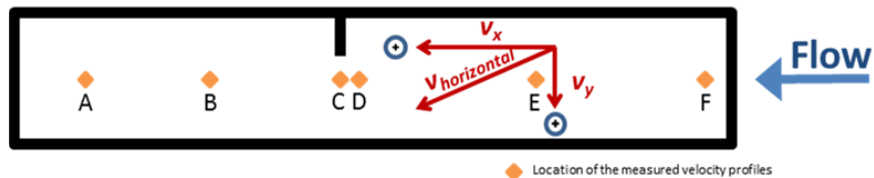
Figure 7. The interpretation of the signs of the velocity vectors.